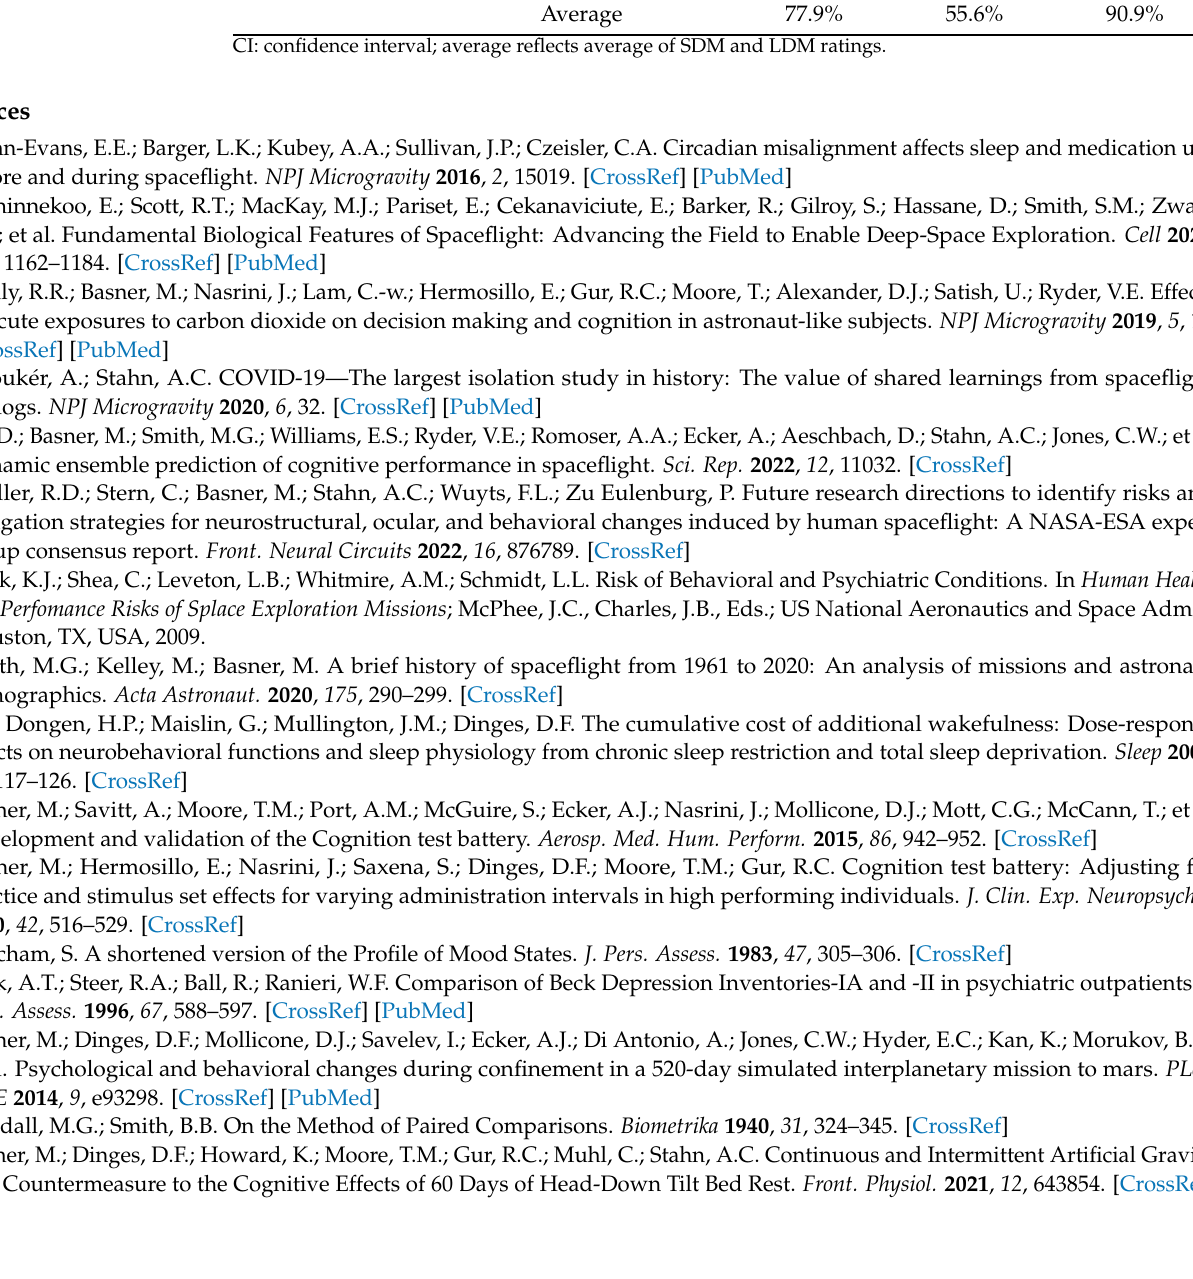
CI: confidence interval; average reflects average of SDM and LDM